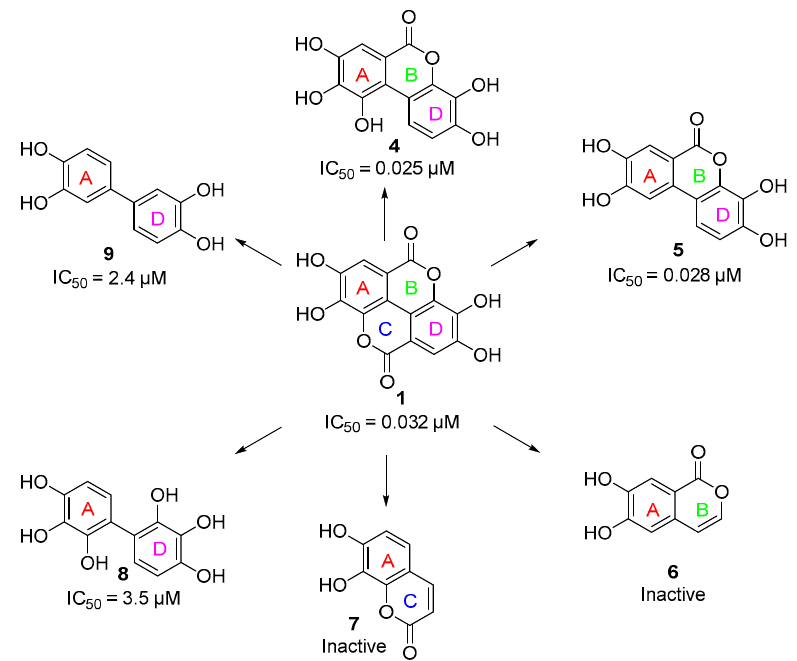
Figure 2. Deconstruction of EA and corresponding IC 50 vs. PKL.